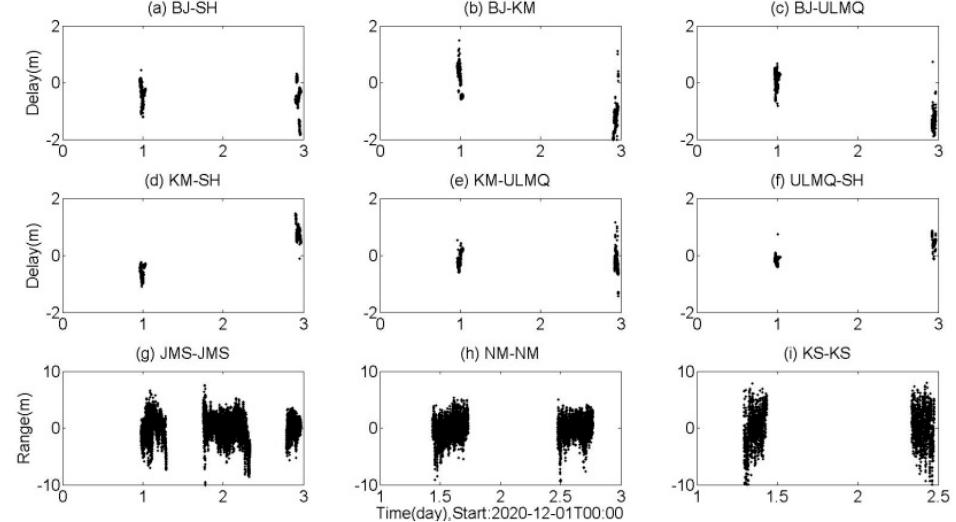
Figure 2. Residuals of radio-tracking computations. Detailed explanations in the text below. Delay stands for VLBI delay residual, BJ-SH stands for Beijing-Shanghai baseline, BJ-KM stands for Beijing-Kunming baseline, BJ-ULMQ stands for Beijing-Urumqi baseline, KM-SH stands for Kunming-Shanghai baseline, KM-ULMQ stands for Kunming-Urumqi baseline and ULMQ-SH stands for Urumqi-Shanghai baseline. Range stands for UXB Range residual, JMS for the Jiamusi station, NM for the South America station and KS for the Kashgar station. According to the analysis, VLBI delay residual error is approximately better than 2 m, and UXB ranging residual error is better than 10 m.